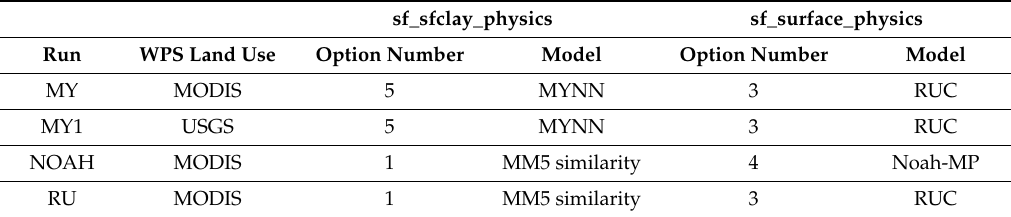
Table 1. Physical parameterization employed in the first four setups of WRF